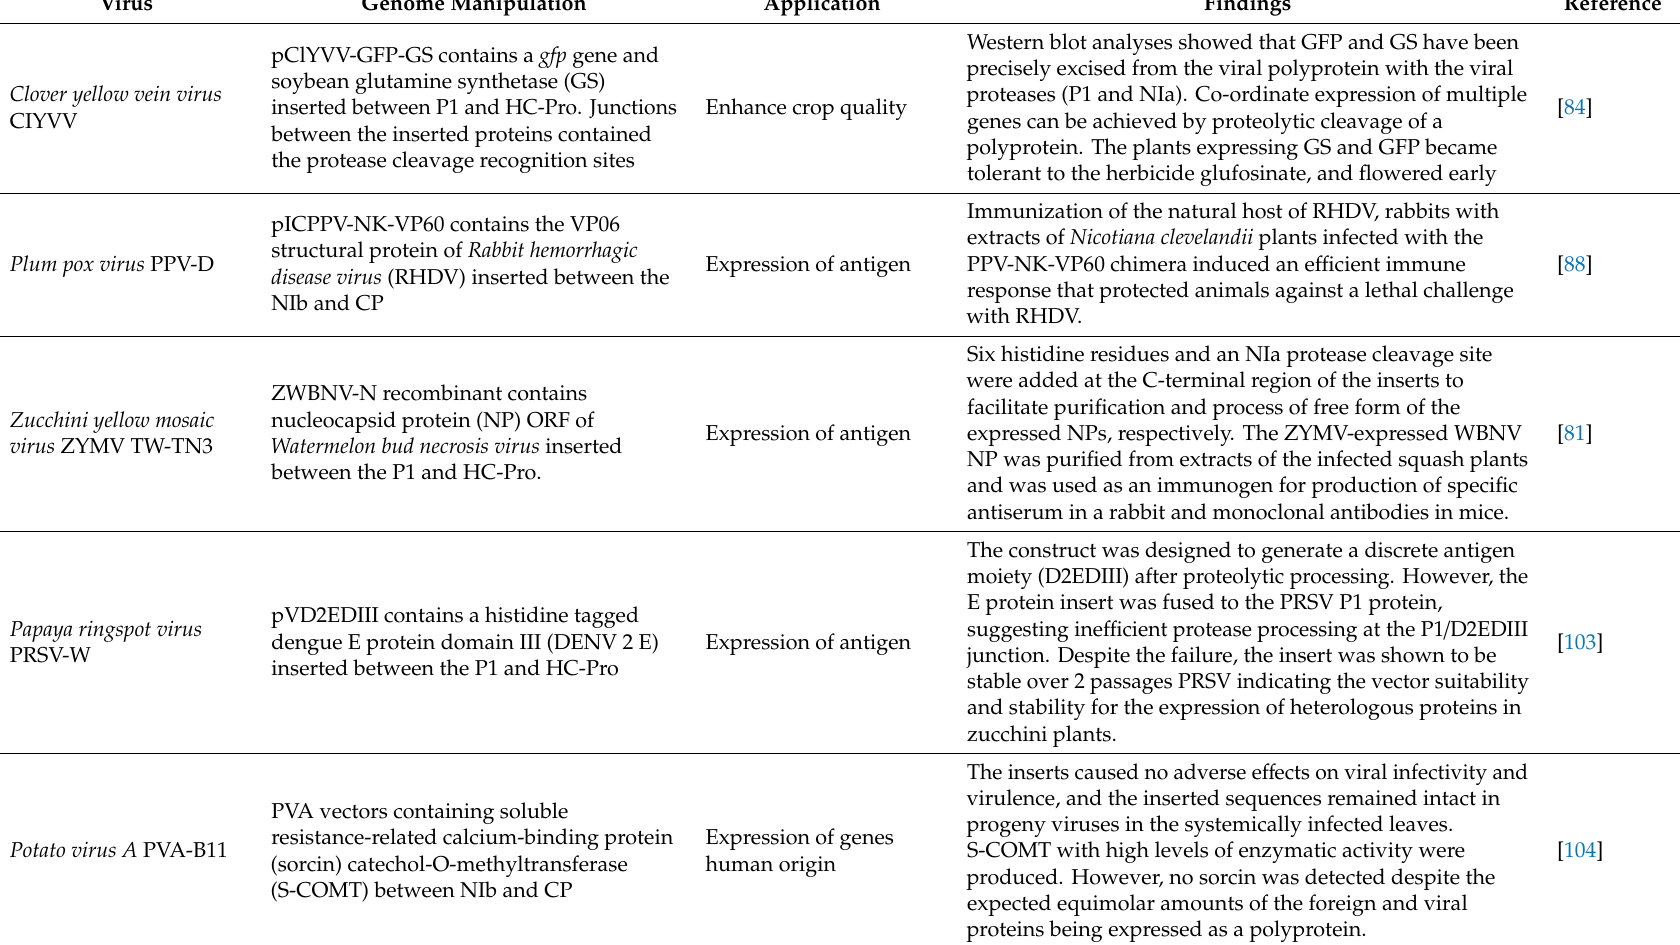
Table 3. Applications of potyviral vectors for the expression of biologically active